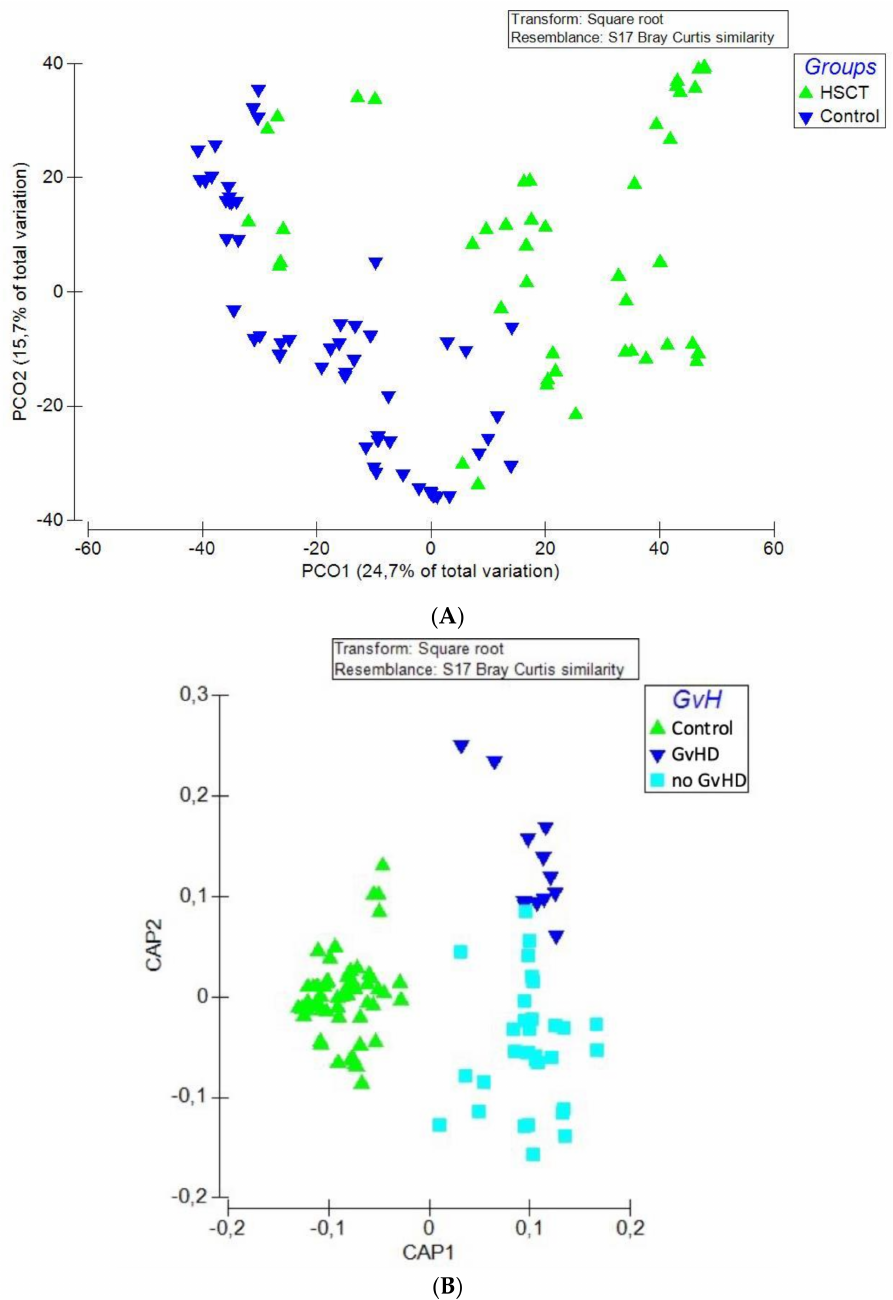
Figure 1. Beta diversity analysis of study groups; ( A ) PCoA plot of the allo-HSCT group (dark blue triangles; n = 15) and the control group (green triangles; n = 18). ( B ) CAP plot of patient groups depending on the occurrence of graft-versus-host disease (GvHD) (dark blue triangles; n = 4), no GvHD (light blue squares; n = 11), and control (green triangles). The data matrix was pre-treated by square-root transformation followed by resemblance analysis based on a Bray–Curtis similarity calculation ( p =